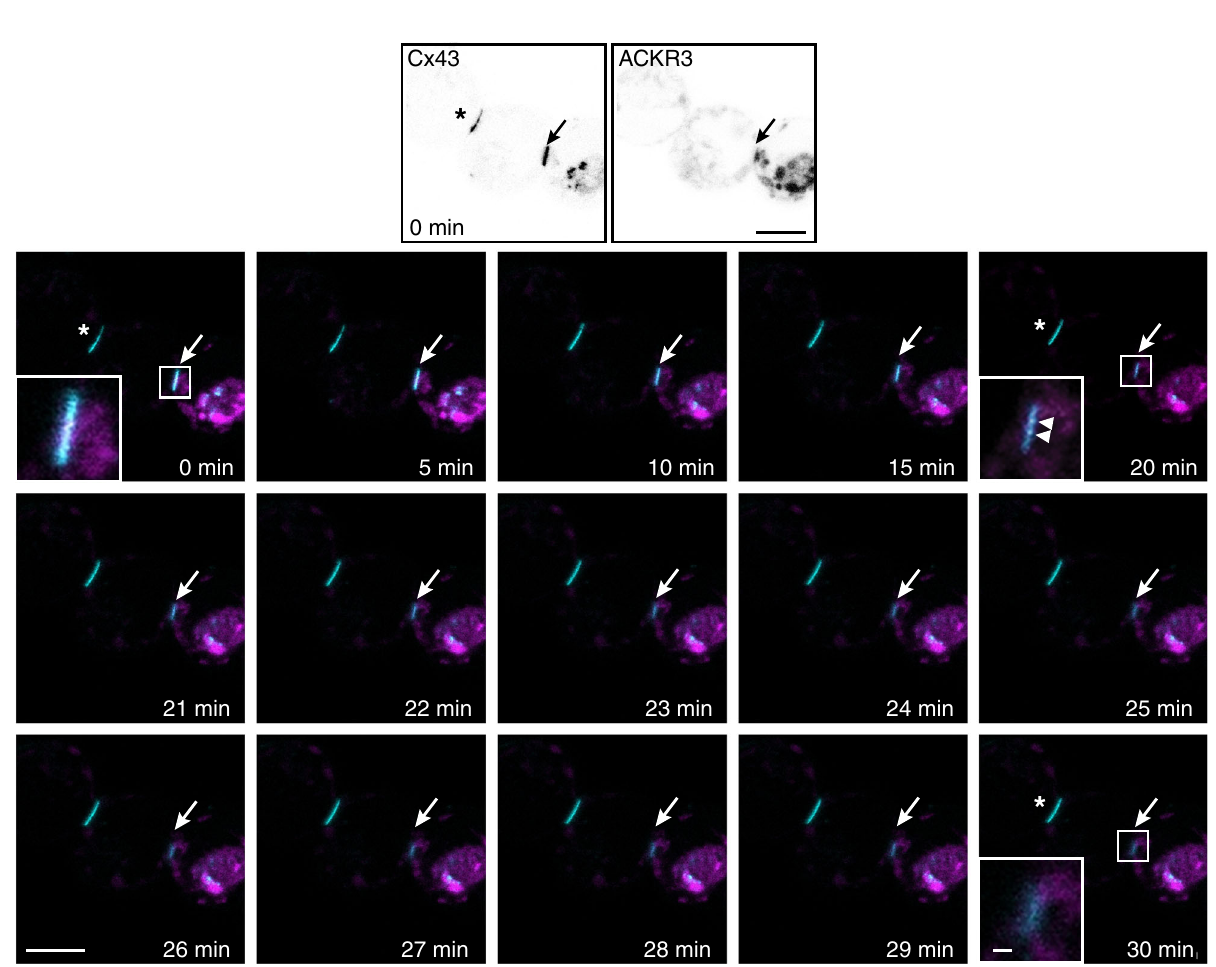
Fig. 5 ACKR3 activation promotes Cx43 internalization. Time-lapse images of gap junction plaques in HEK293T cells co-expressing Cx43-GFP and RedCherry-ACKR3 and exposed to CXCL12 (10 nM) for 30 min. The two upper images show GFP (Cx43, left panel) and RedCherry (ACKR3, right panel) fl uorescence signals, respectively, before the onset of chemokine application. Images below show Cx43-GFP fl uorescence at the times indicated. A zoomed image of a Cx43-GFP plaque is illustrated at 0, 20 and 30 min in the left bottom corner of the image. The arrows show the removal of the plaque and the arrowheads Cx43-GFP vesicle budding. The decrease in Cx43-GFP fl uorescence was not due to photobleaching, as CXCL12 exposure did not induce the removal of a gap junction plaque located at the interface of cells that do not express ACKR3 (*). Scale bars = 10 and 1 μ m for time-lapse and magni fi ed pictures, respectively. See the Statistics and Reproducibility section for the number of